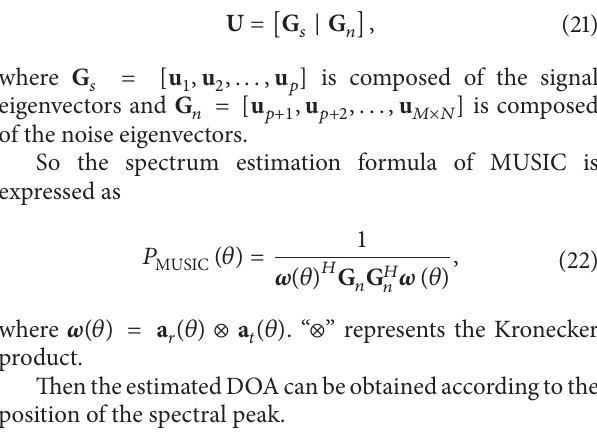
Figure 2: Mean error of target 1.